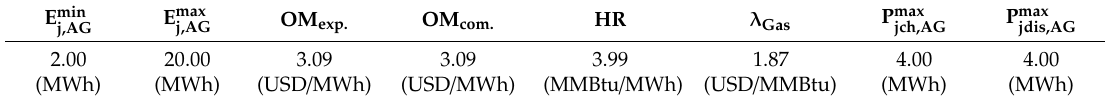
Table 6. Input data of the compressed air energy storage system.